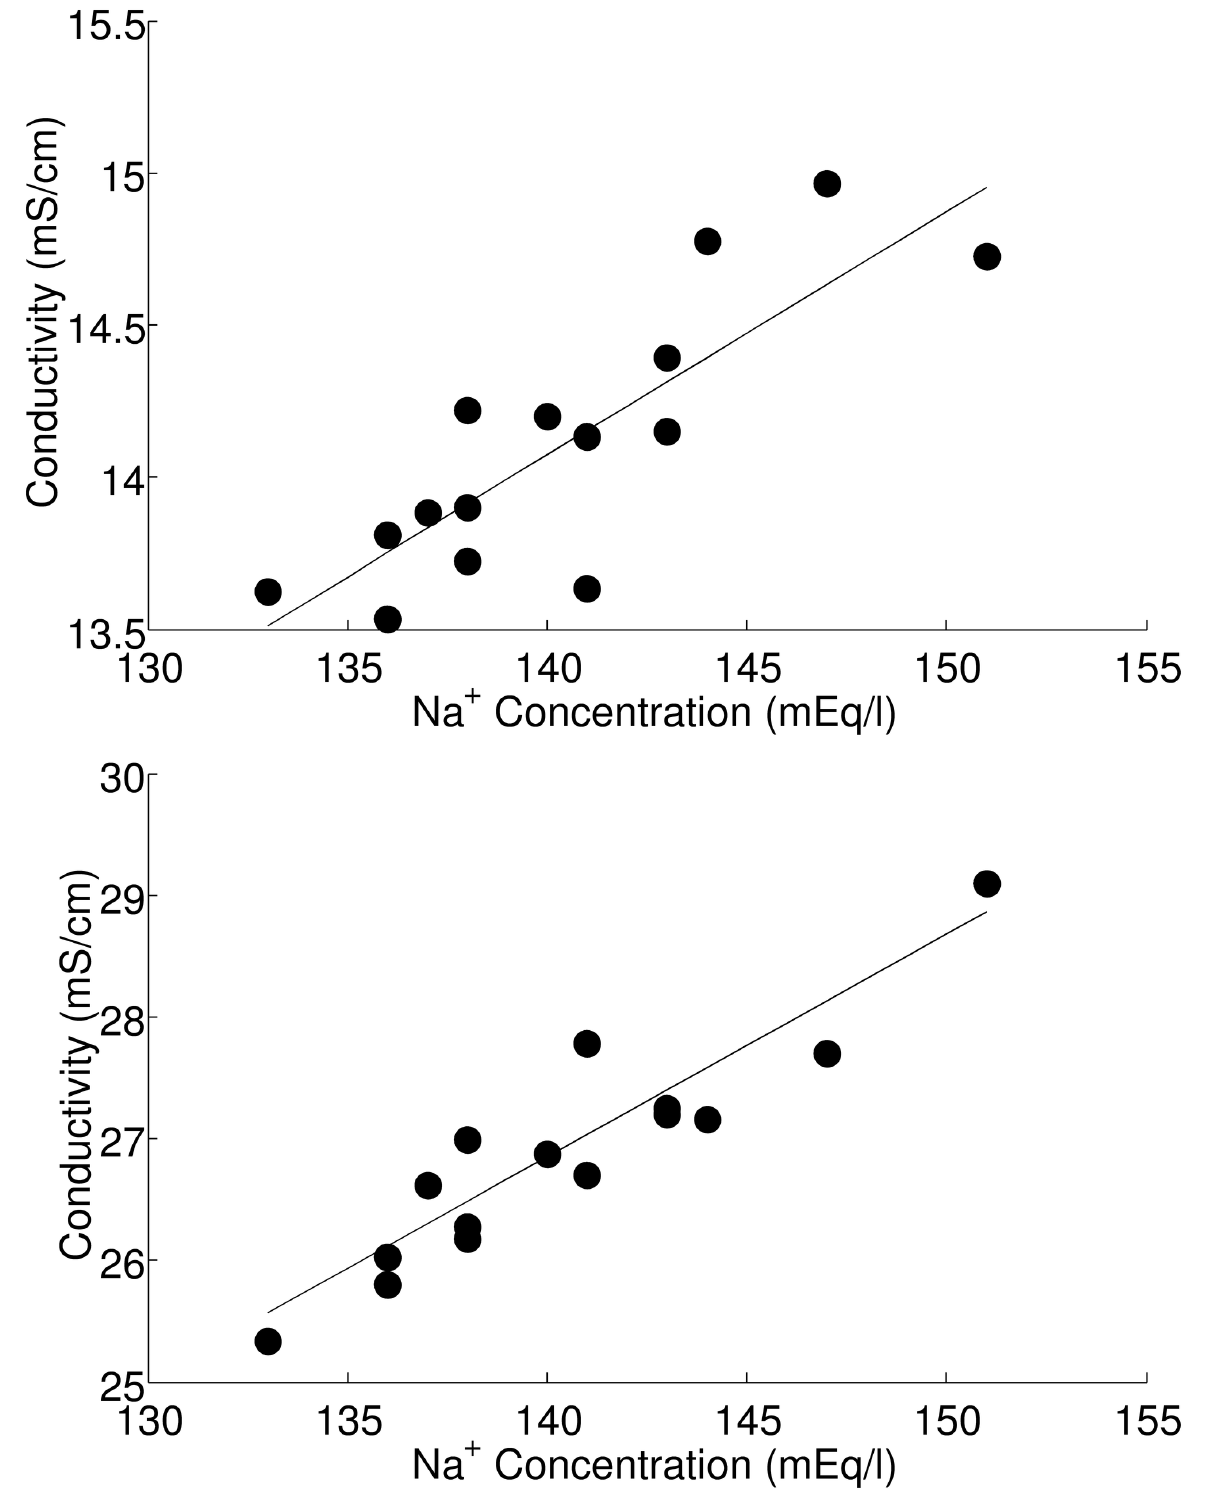
Figure 1. Conductivity of the dialysate solution samples in relation to sodium concentration. Conductivity is reported before (top) and after (bottom) treatment with ion-exchange resin. R was 0.839 and 0.924, respectively, P<0.0001. Regression equation was y = 0.08x+2.87 and y=0.18x+1.23.